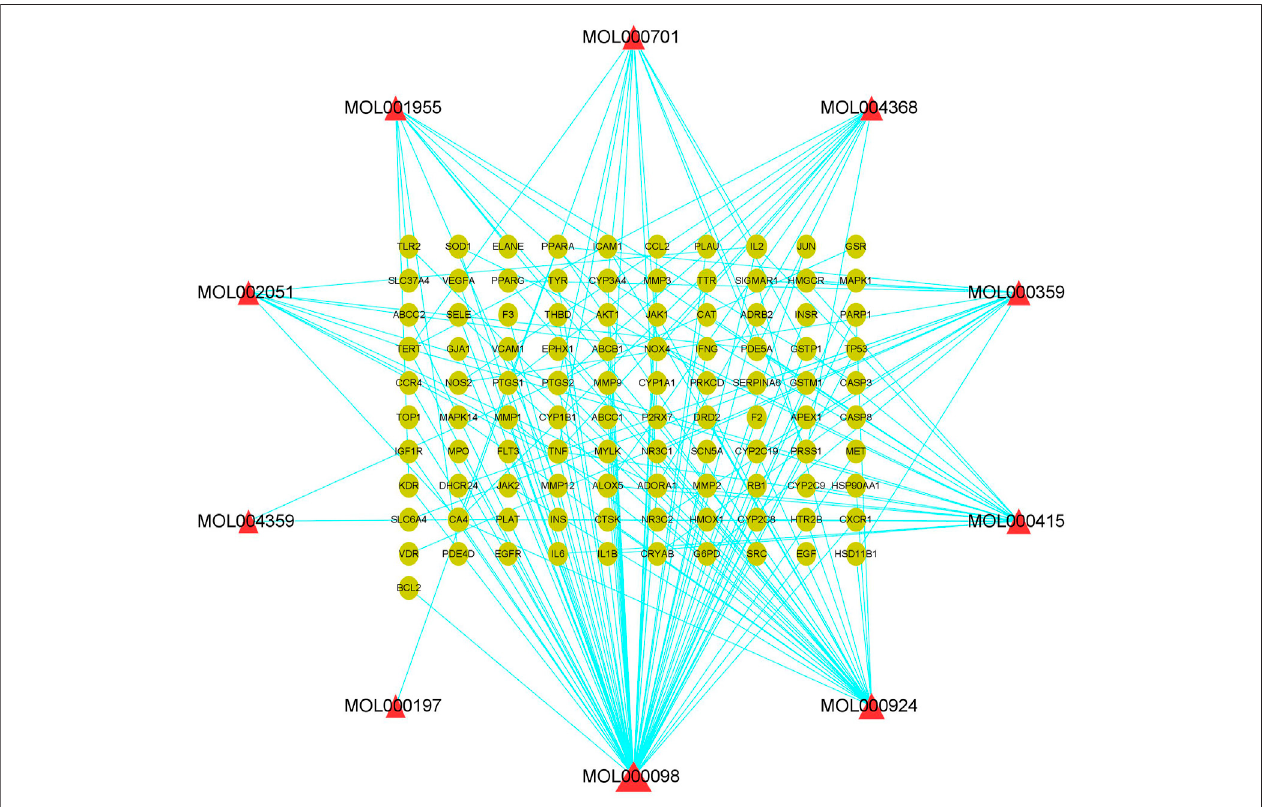
FIGURE 3 | Component target network of 10 active ingredients of H. cordata against pulmonary fi brosis, in which triangles represent active ingredients and dots are action targets.